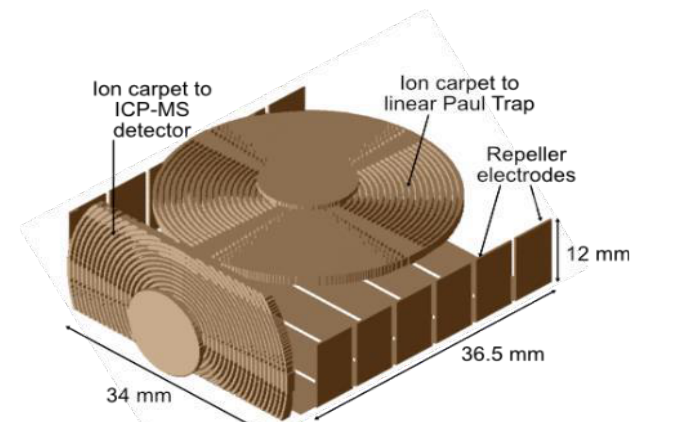
Fig. 3 . SIMION 3D representation of the ion extraction unit. A series of repeller plates perpendicular and opposite to two ion carpets.